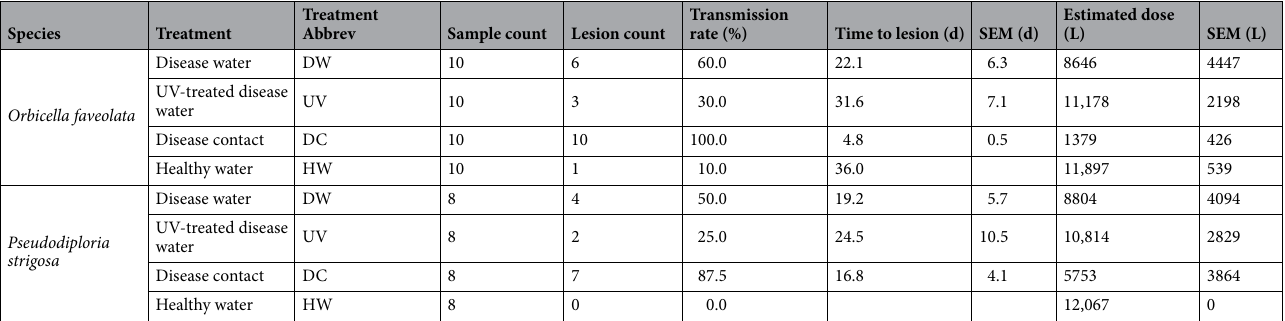
Table 1. UV experiment transmission metrics. Transmission rates (proportion of individuals exhibiting SCTLD lesions), mean ± SEM time to onset of lesions in days, and estimated water dose ± SEM in liters needed to elicit disease